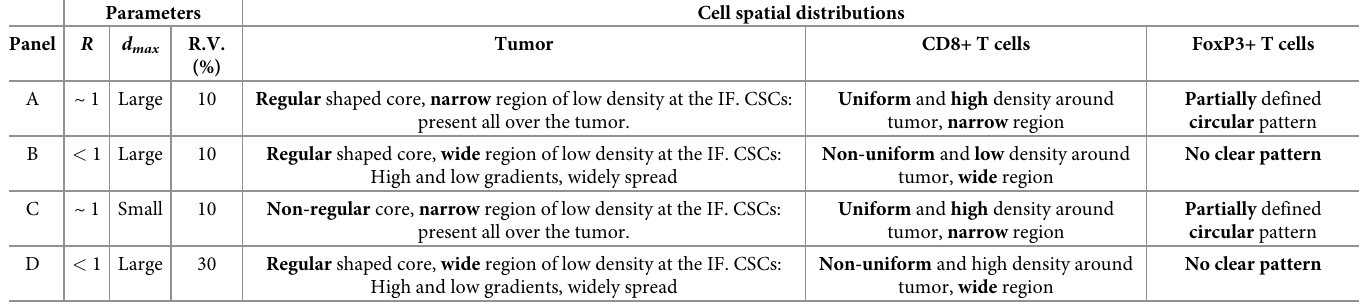
Table 2. Spatial characterization of the immune response under different tumor growth conditions. R.V. stands for recruitment volume and refers to the percentage of spatial domain occupied by voxels with cell recruitment points (where only one recruitment point is assumed per voxel); CSCs denotes cancer stem-like cells. Parameters Cell spatial distributions Panel R R.V. Tumor CD8+ T cells (%) Regular shaped core, narrow region of low density at the IF. CSCs: Uniform and high density around Partially defined present all over the tumor. tumor, narrow region circular pattern Regular shaped core, wide region of low density at the IF. CSCs: Non-uniform and low density around No clear pattern High and low gradients, widely spread tumor, wide region 10 Non-regular core, narrow region of low density at the IF. CSCs: Uniform and high density around Partially defined present all over the tumor. tumor, narrow region circular pattern 30 Regular shaped core, wide region of low density at the IF. CSCs: Non-uniform and high density around No clear High and low gradients, widely spread tumor, wide region